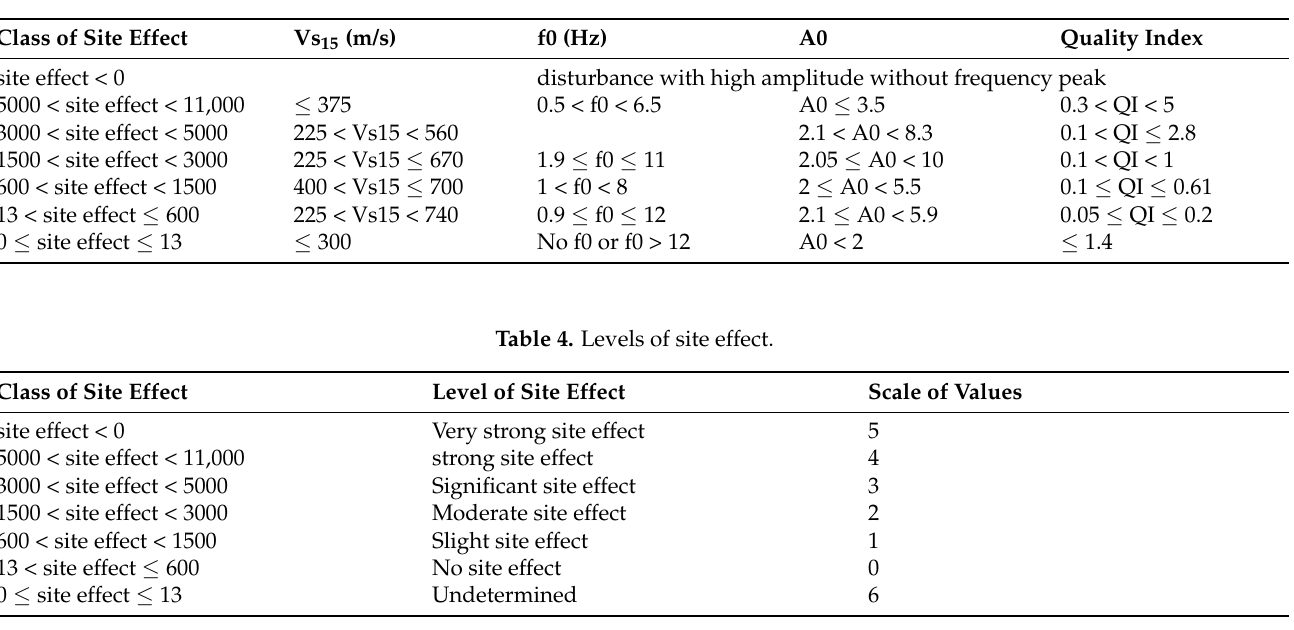
Table 3. Classes of site effect obtained by the multiplication of the reference numbers parameter by parameter.